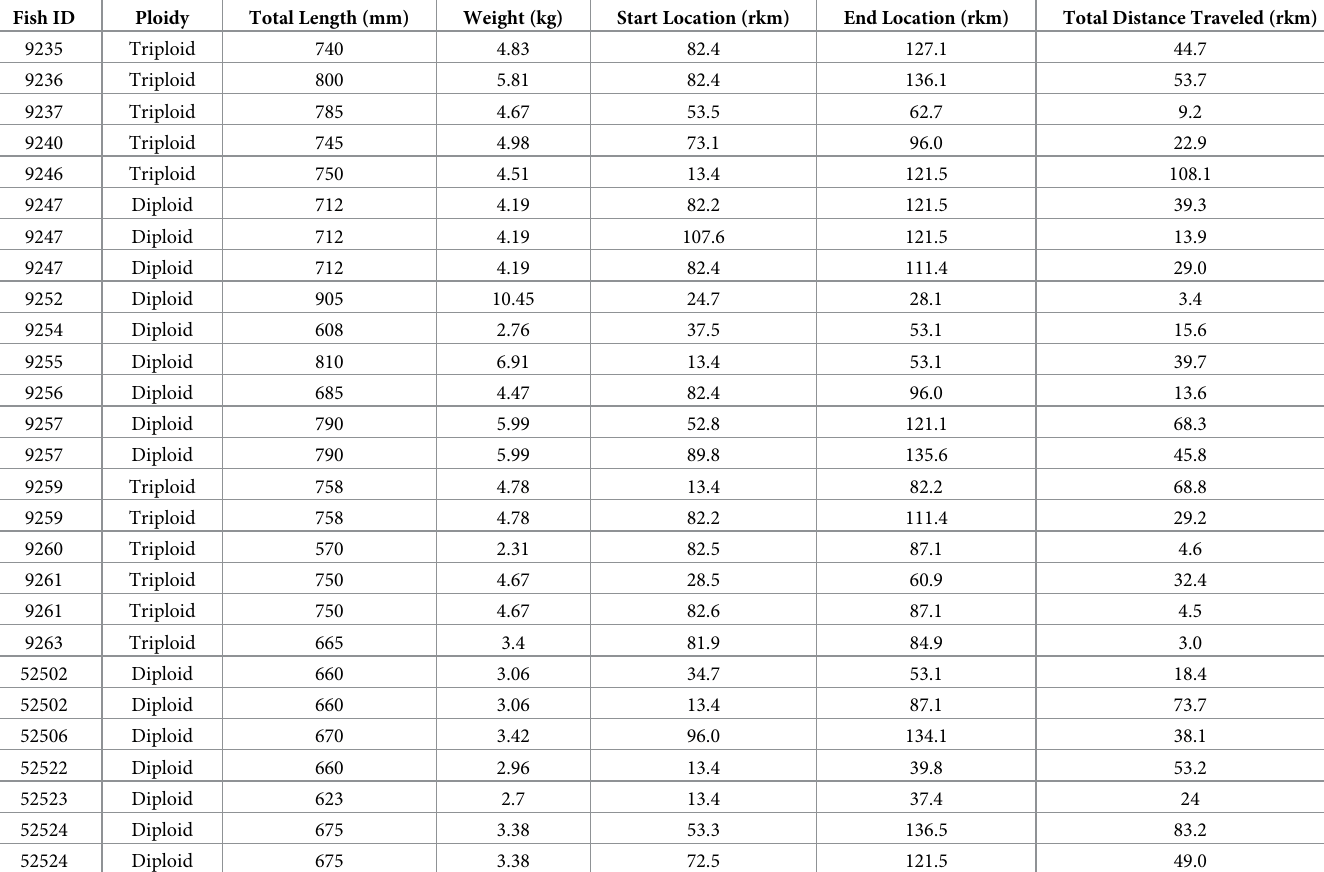
Table 1. Upstream migrations for 20 tagged grass carp Ctenopharyngodon idella in Truman Reservoir, Missouri in 2019. Total lengths in millimeters (mm) and weights in kilograms (kg) were at time of tag implantation. Distance traveled measured in river kilometers (rkm) upstream from Truman Reservoir